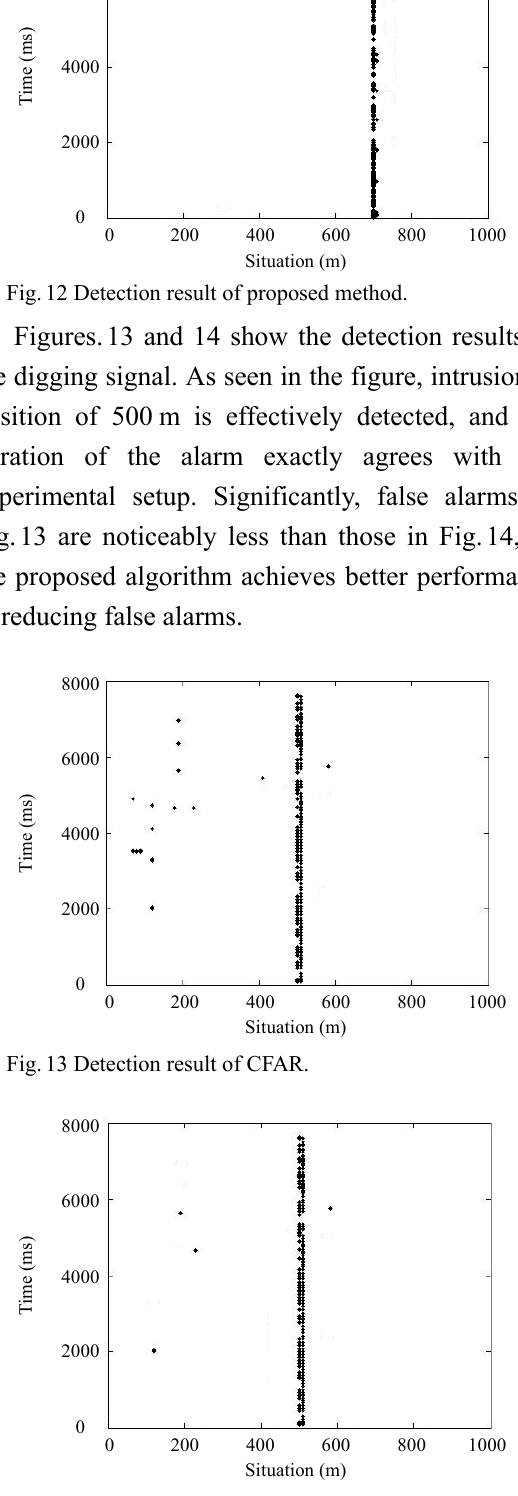
Fig. 14 Detection result of proposed